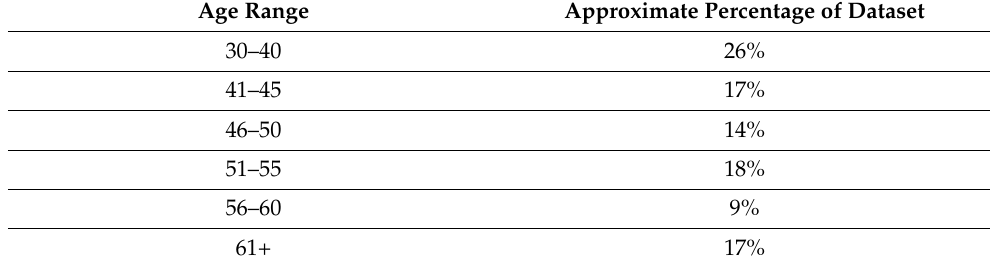
Table 2. Revised patient age